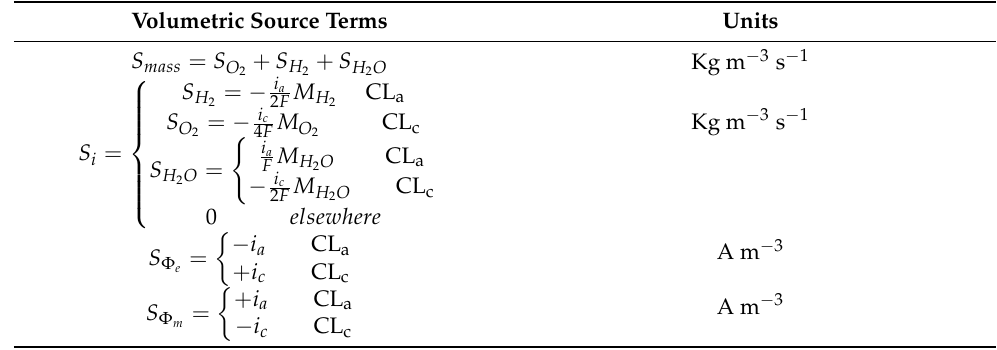
Table 1. Source terms of the conservation